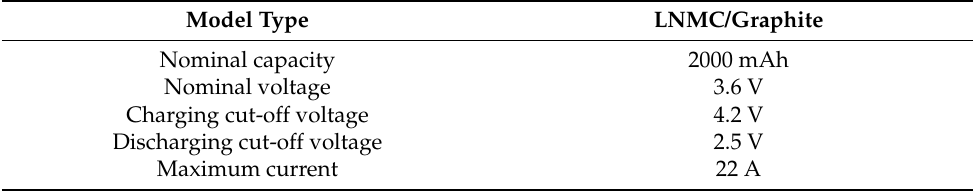
Table 1. Specifications of INR 18650-20R Li-ion